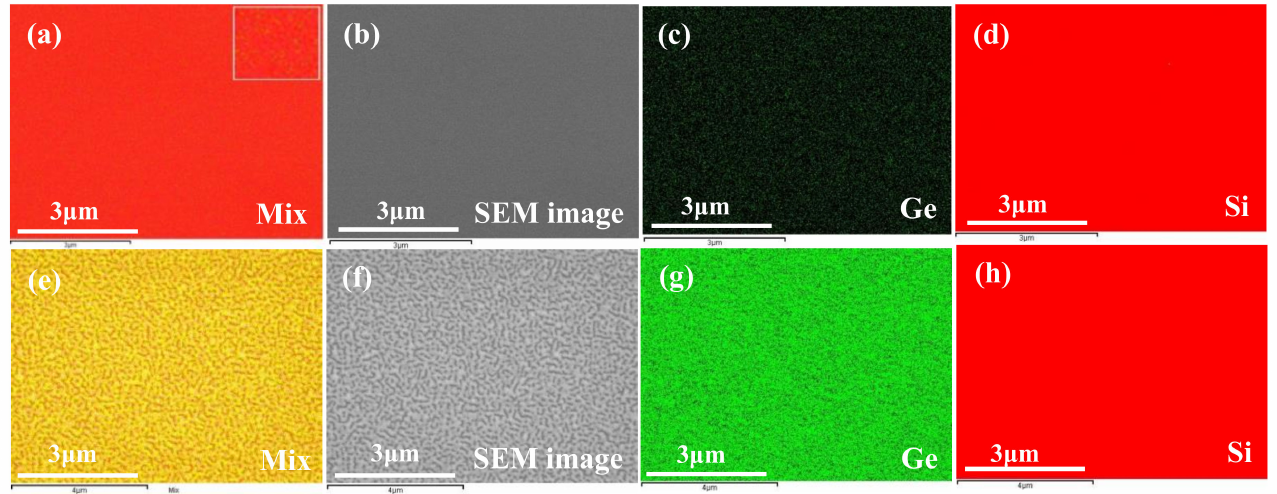
Figure 3. EDS analysis for Ge deposition time of 25 s ( a – d ) and 240 s ( e – h ). For 25 s, ( a ) mix, ( b ) SEM image, ( c ) extracted result of Ge as epilayer, and ( d ) extracted result of Si as substrate; for 240 s, ( e ) mix, ( f ) SEM image, ( g ) extracted result of Ge as epilayer, and ( h ) extracted result of Si as substrate.